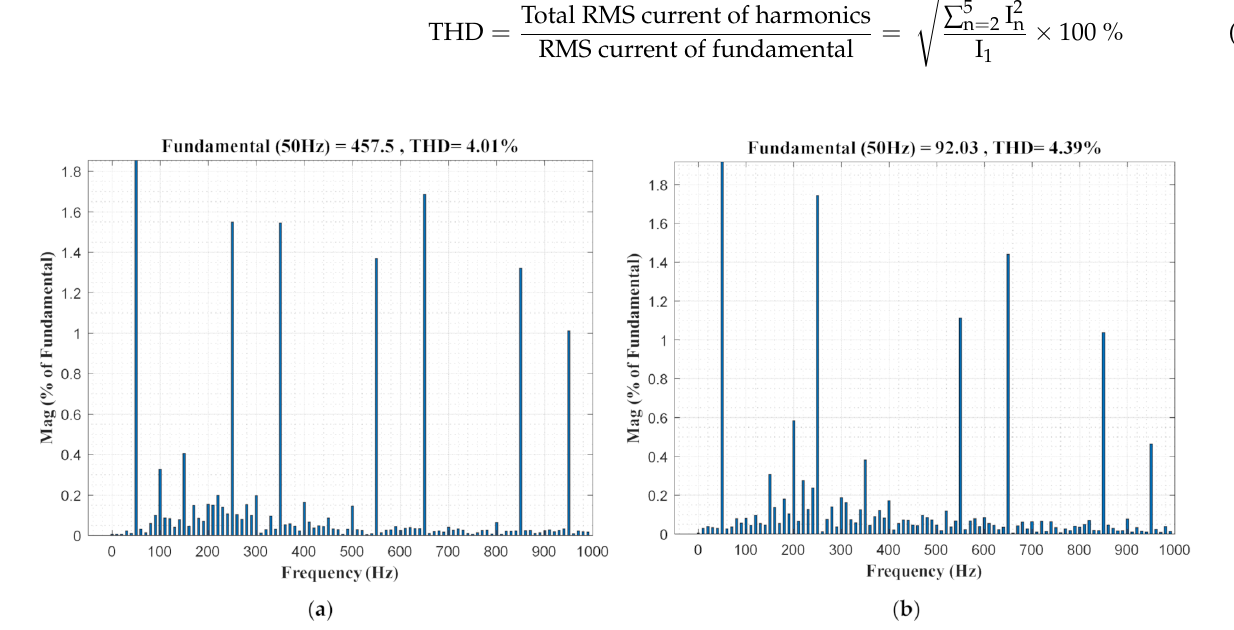
Figure 9. THD of line current; ( a ) full load, ( b ) 20% load following the standards < 5%.